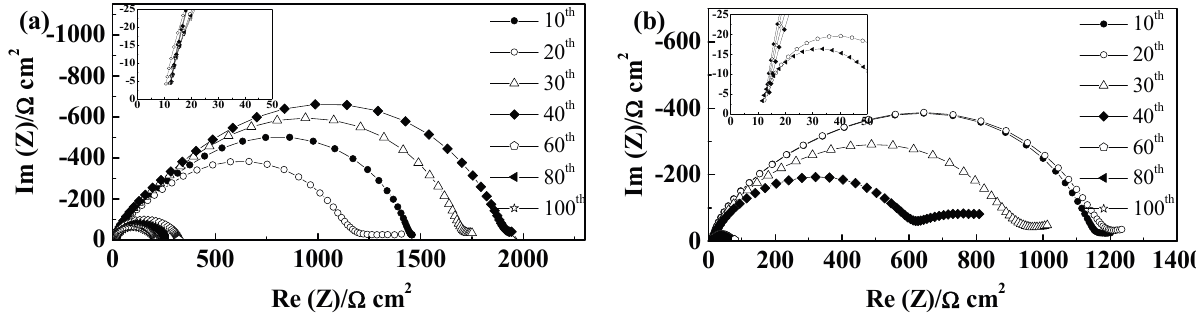
FSI cell; and ( b ) PYR FSI 14 12O1